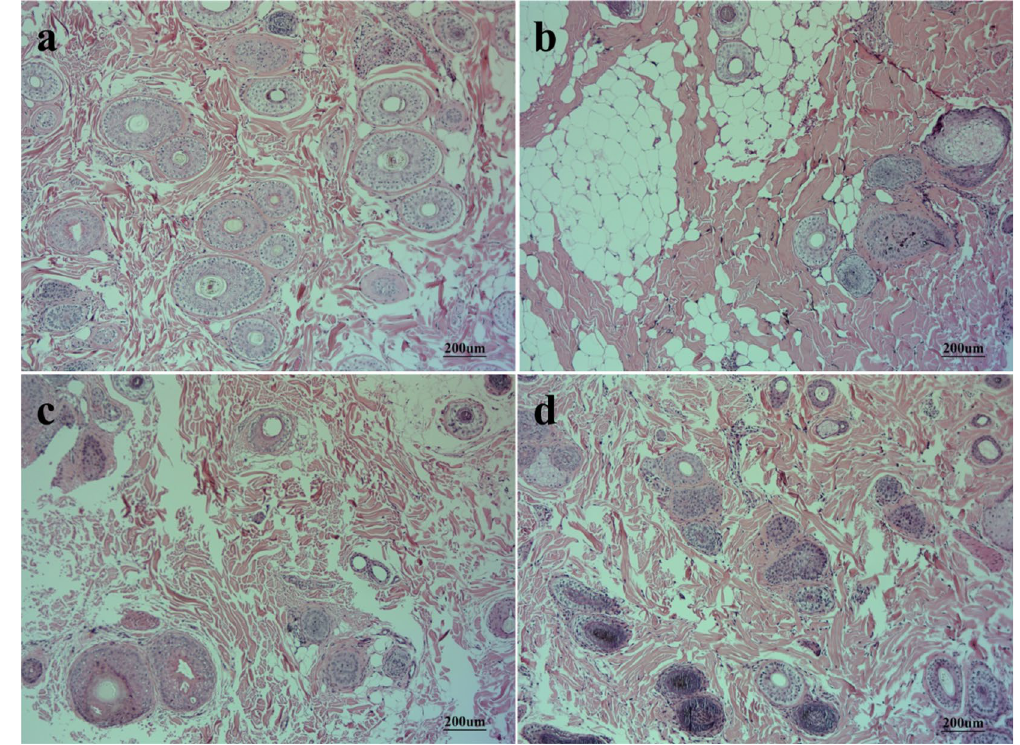
Figure 4. Histopathological characteristics of a transverse skin section at the reticular dermis layer of Formosan macaques with and without symmetrical alopecia. ( a ) C2016091201, individual with normal hair appearance; ( b ) 2016080401; ( c ) 2016080402; and ( d ) 2016080403 were three individuals with symmetrical alopecia. A higher proportion of catagen/telogen was noted in macaques with alopecia than in those with normal hair